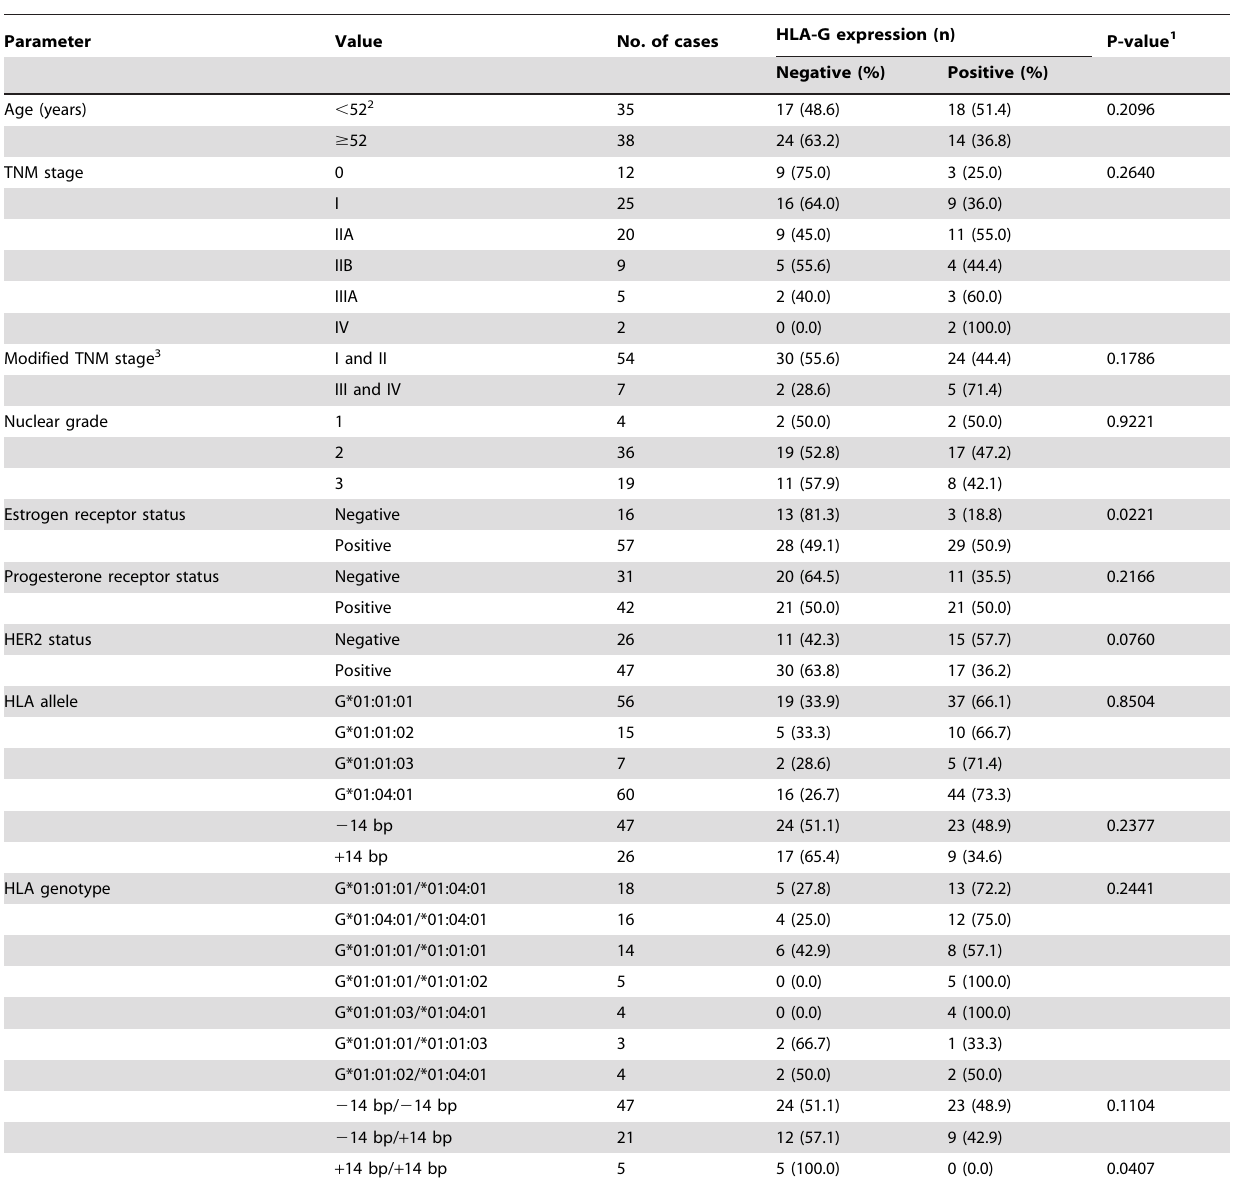
Table 4. Association of HLA-G expression in cancer lesions with clinicopathological parameters, and HLA-G 14-bp sequence status.